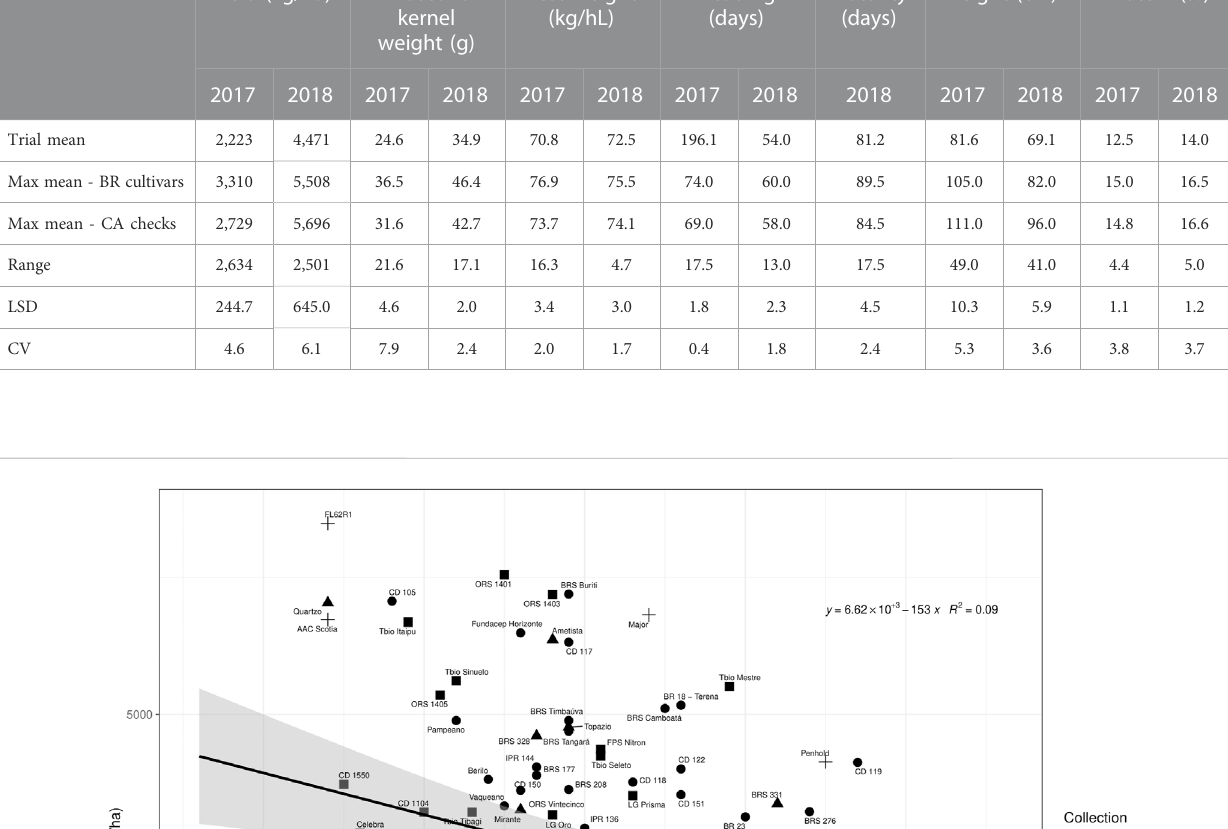
of the fl ag leaf infected with leaf rust, %) was rated near maturity at the point of maximum infection using the modi fi ed Cobb scale (Peterson e t al., 1948). The entire collection was tested for leaf rust resistance in nurseries at Morden in 2017 and 2018, collection ‘ B ’ was also evaluated at Morden in 2016.